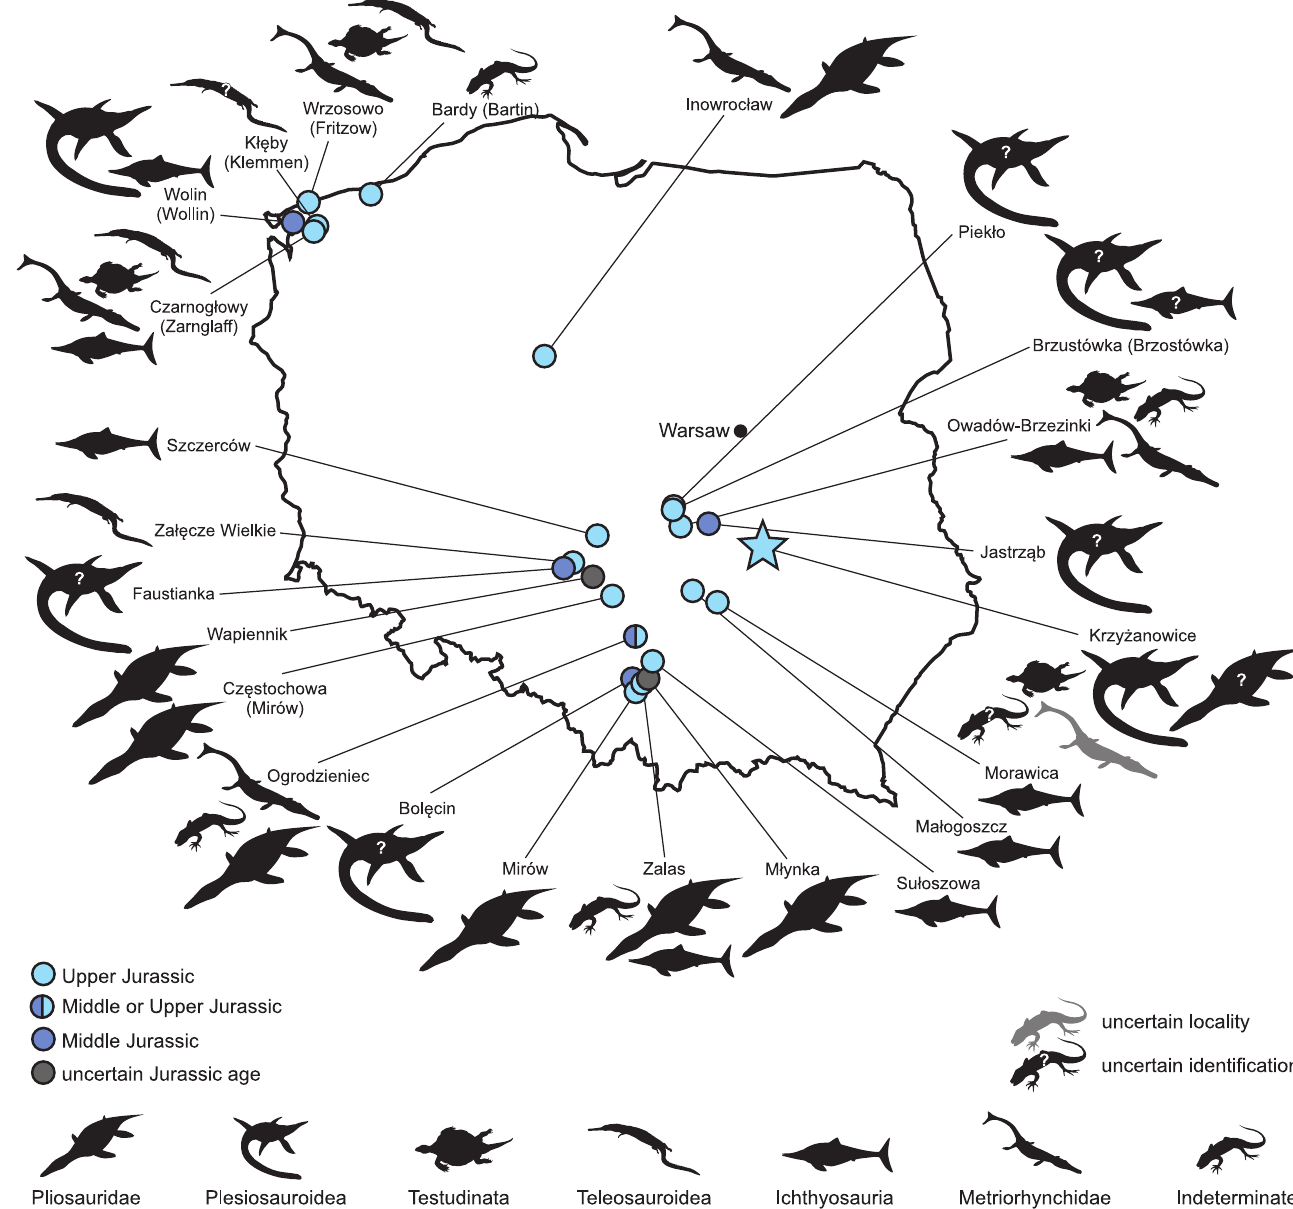
Fig. 1. Geographic distribution of Jurassic marine reptile fossil occurrences in Poland. See Table 1 for details. Silhouettes obtained from phylopic.org: Geosaurinae (Dmitry Bogdanov, CC BY 3.0), Ichthyosauria, Metriorhynchinae, and Teleosauroidea (Gareth Monger, CC BY 3.0), indeterminate reptile clade (public domain), Plesiosauroidea (Adam Stuart Smith, CC BY-SA 3.0), Pliosauridae (Nobu Tamura, CC BY-SA 3.0), and Testudinata (public